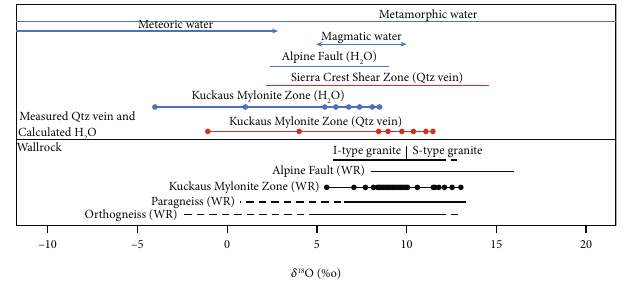
Figure 11: The ranges of δ 18 O values determined for samples from the KMZ. Whole rock values are in black, and the quartz veins are in red. Also plotted (in blue) are calculated H O compositions for the 2 quartz veins using the fractionation factor of Matsuhisa et al. [66]. Also shown are the ranges of meteoric, metamorphic, and magmatic waters, as well as typical I- and S-type granite and para- and orthogneiss whole rock values. The dashed line part of the para- and orthogneiss ranges are inferred to be a ff ected by secondary processes. The Sierra Crest Shear Zone quartz vein [48] and the Alpine Fault whole rock and H O [40] ranges are also 2 shown for comparison. Table of references and δ 18 O values for para- and orthogneiss ranges are provided in supplements (Table S4).